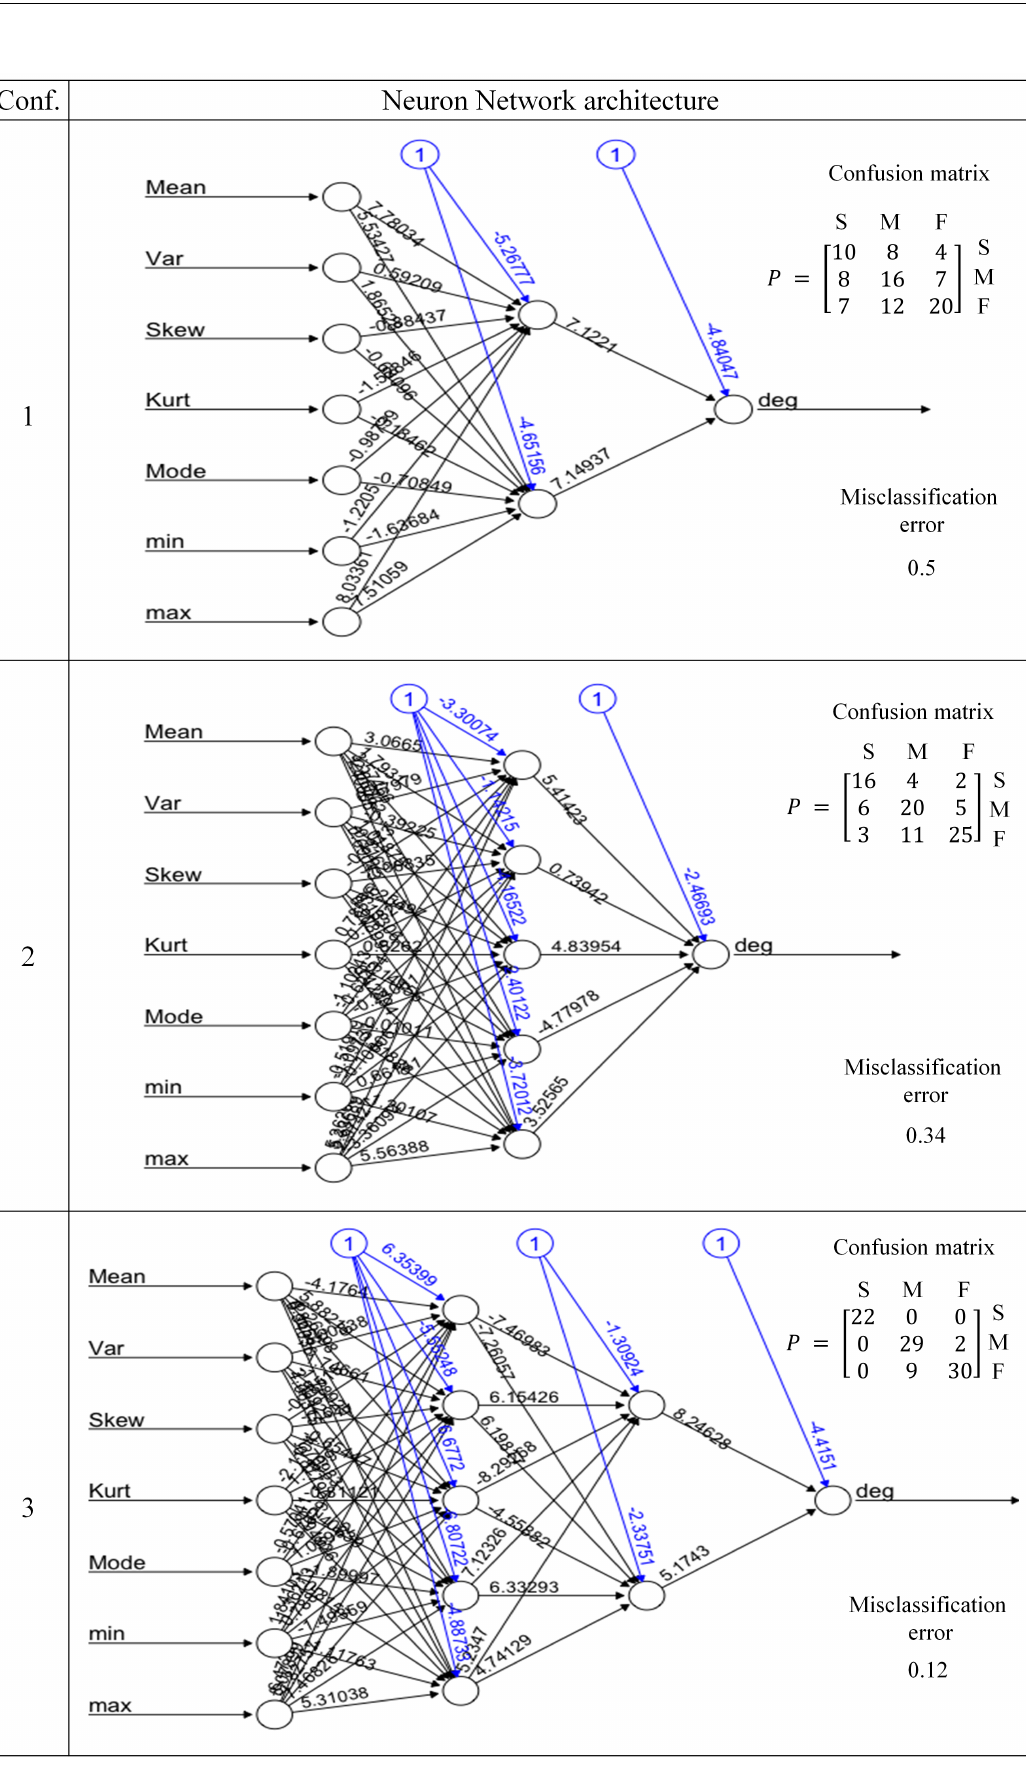
Figure 15. NN prediction results for real data: (S—Slow, M—Moderate, and